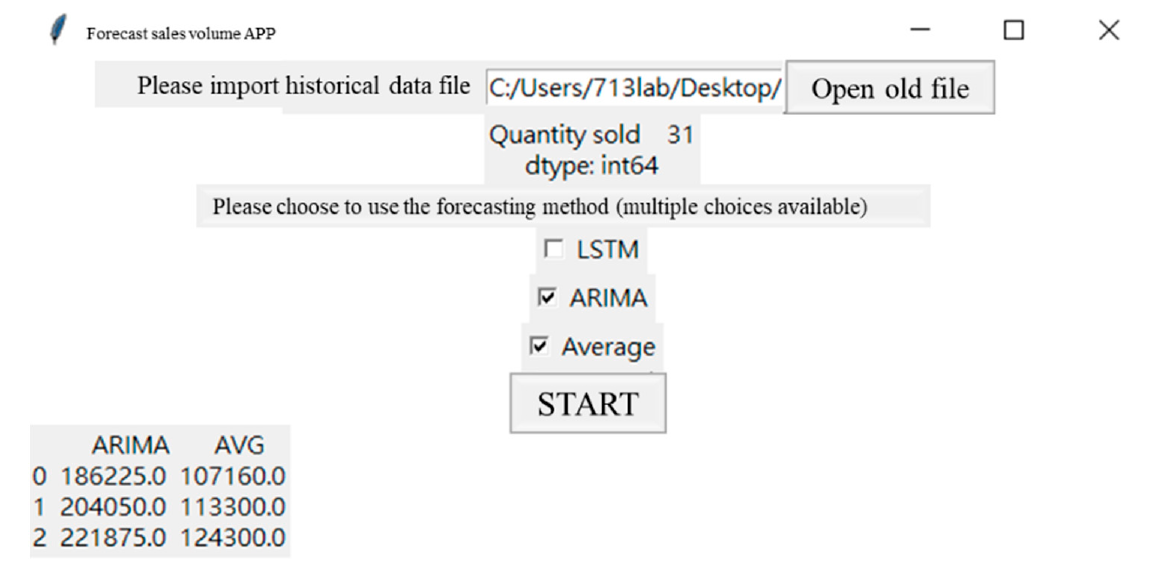
Figure 9. The number of periods filtered indicates.